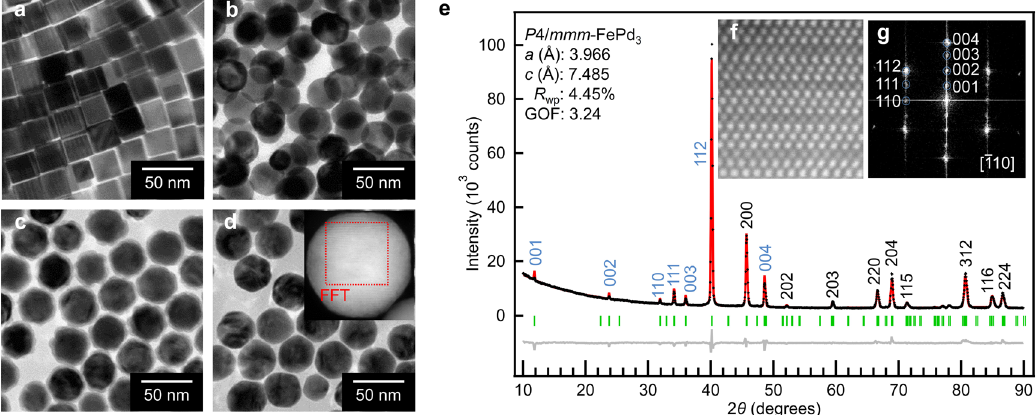
Fig. 1 Synthesis and characterization of monodisperse Fe – Pd alloy NPs with a small amount of In. a – d , TEM images of 23-nm Pd NPs ( a ), A 1-PdIn x NPs with Pd/In = 82/18 at.% ( b ), A 1-PdIn x @FeO y core@shell NPs with Pd/Fe = 73/27 at.% ( c ) and the NPs obtained by the reductive annealing of c at 600 °C for 3 h ( d ) (the inset shows the HAADF-STEM image of d ). e , Rietveld re fi nement for powder XRD patterns of the NPs obtained by the reductive annealing of c at 800 °C for 3 h, where the black markers are raw data, the red is the fi tting curve, the gray line is a difference curve of raw data and the fi tting curve, and the green bars stand for the whole diffraction-peak positions. R wp and GOF are a reliability factor and a goodness of fi t, respectively. f , g . Magni fi ed HAADF-STEM image ( f ) and the fast Fourier transform (FFT) image ( g ) of the inset in d